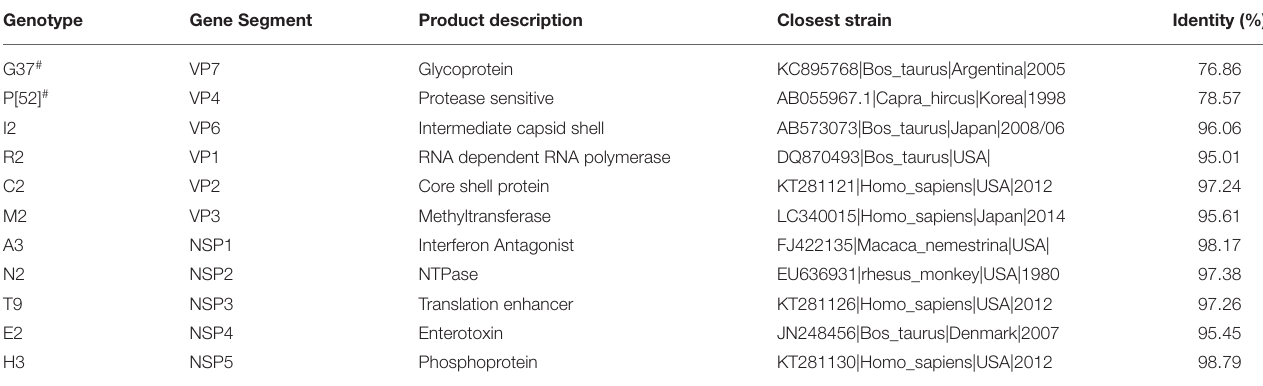
TABLE 1 | Novel bovine rotavirus A genotyping and strains with the highest nucleotide identity.